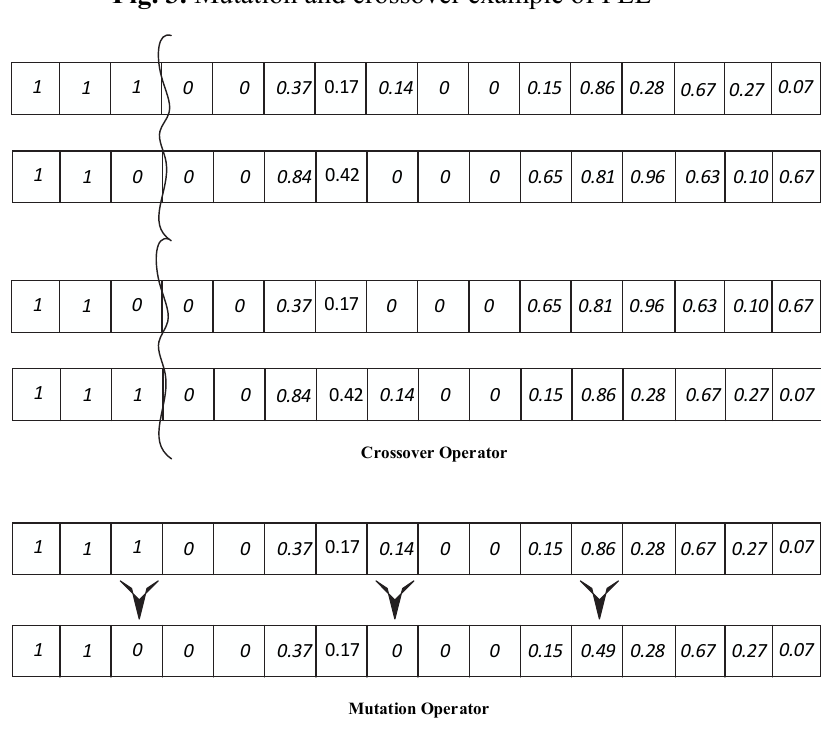
Fig. 3. Mutation and crossover example of FEL